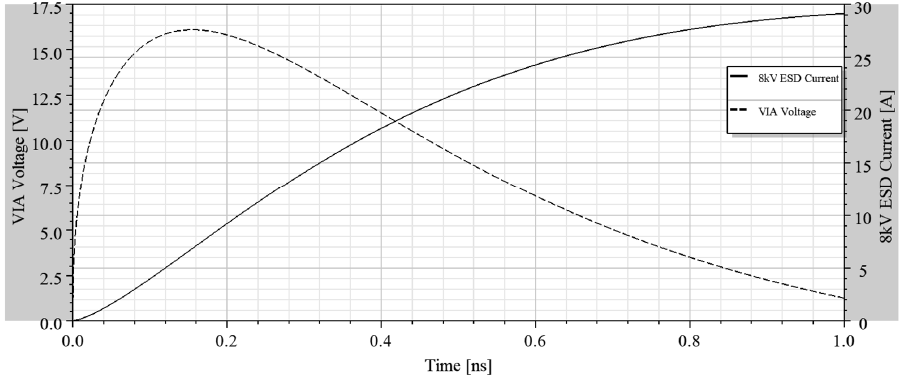
Figure 11. Simulation results of an 8 kV ESD effect on a VIA that connect a TVS to ground. VIA is characterized by parasitic inductances equal to 304.9 pH.